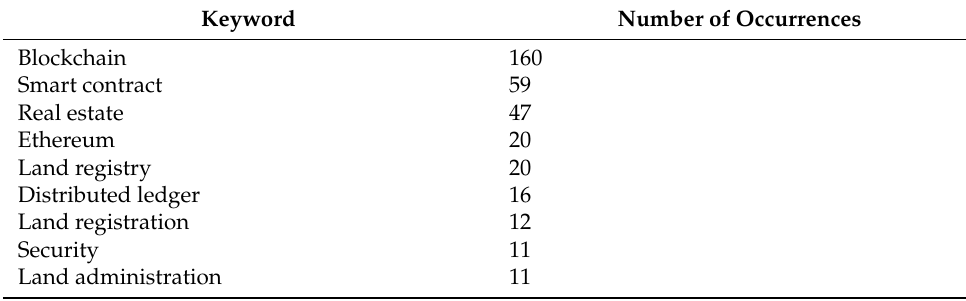
Table 1. Literature’s ten most-often-used author keywords. Keyword